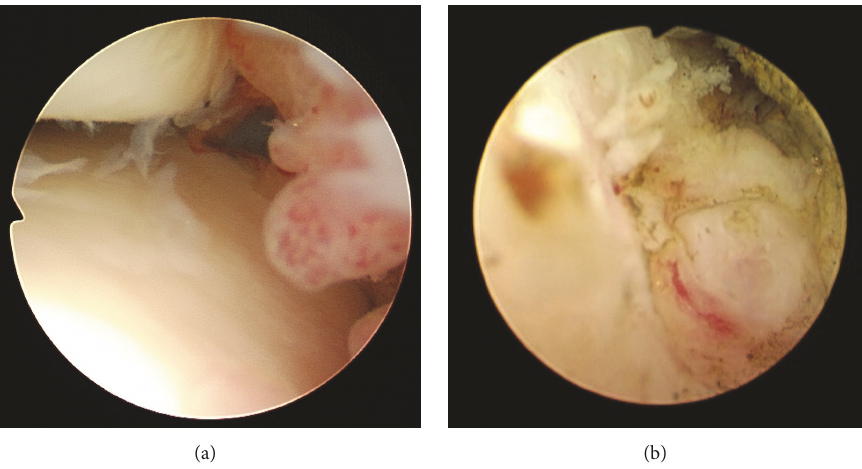
Figure 4: (a) Arthroscopy of the left ankle joint. Hyperplasia with hyperemia of the joint synovium was noted. (b) After synovectomy, a red subperiosteal lesion was seen through the thinned cortex of the talar neck.